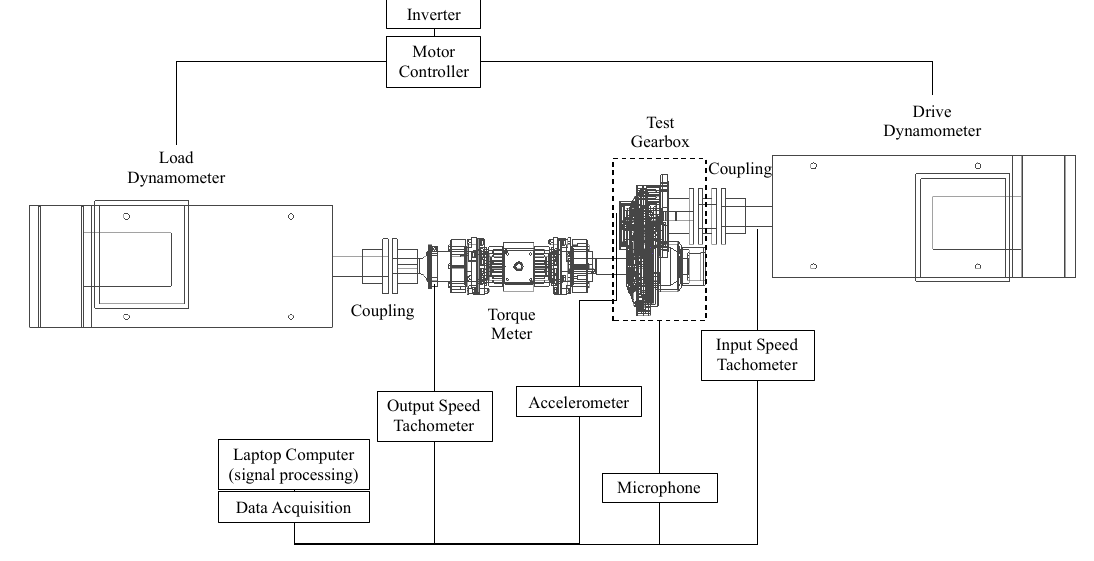
Figure 3. Test layout for order analysis. Table 3. Specification of test equipment for order analysis.